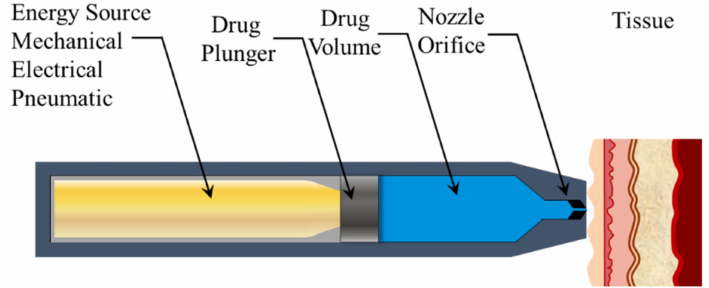
Figure 1. Working principle of an oversimplified model of a needle-free jet